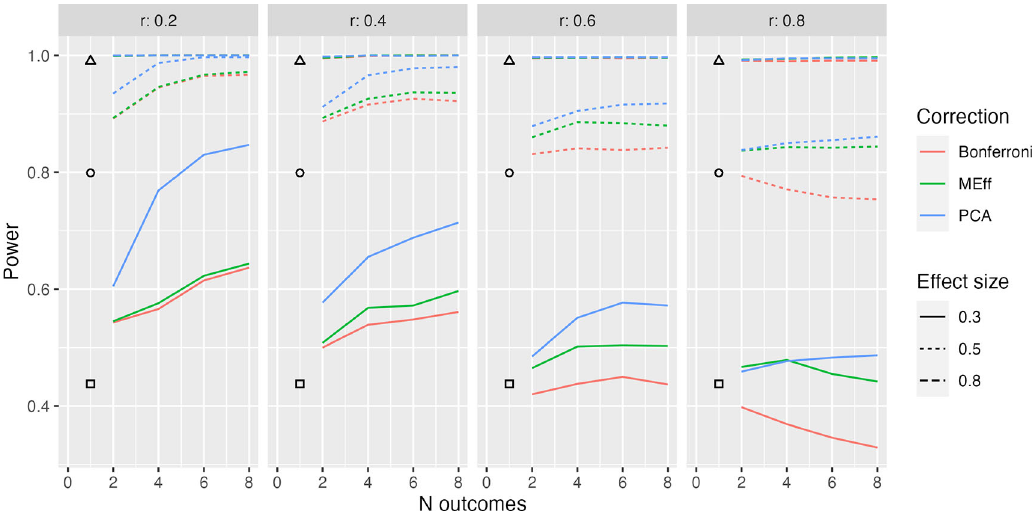
Figure 2.ModelL1, 50pergroup. Powerinrelation tonumber ofoutcomemeasures (Noutcomes),intercorrelation between outcomes (column headers), type of Correction, and Effect size. The square, circle and triangle symbols represent the power for a single outcome measure with effect size .3, .5 and .8 respectively.